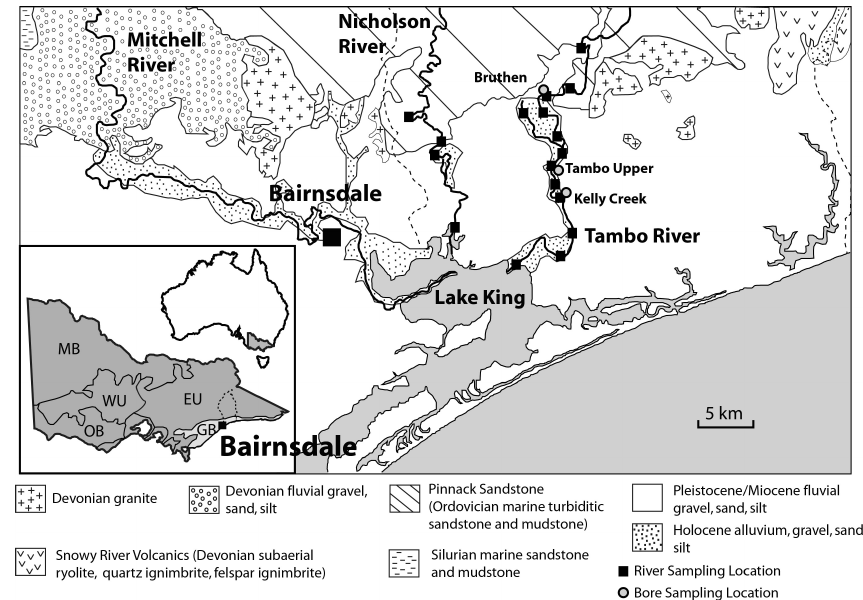
Fig. 1. Map of the Tambo River Basin (dashed line) with sampling locations on Tambo and Nicholson rivers, and local surface geology (modified from Jolly, 1997). GB=Gippsland Basin, EU=Eastern Victorian Uplands, WU=Western Victorian Uplands, OB=Otway Basin, MB=Murray